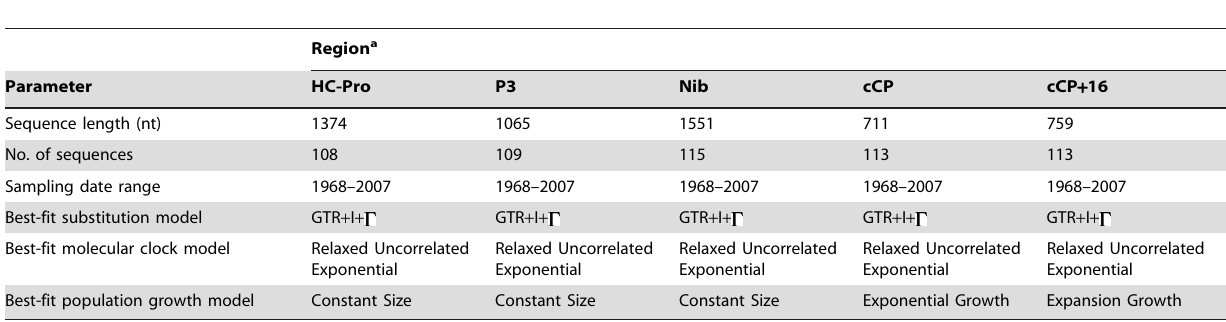
Table 2. Details of the data sets used for estimation of nucleotide substitution rate and time to the most recent common ancestor.